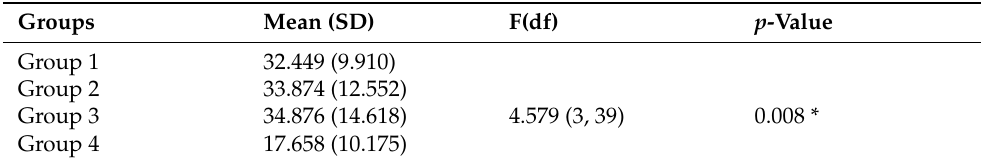
Table 3. Microhardness measurement of all groups.